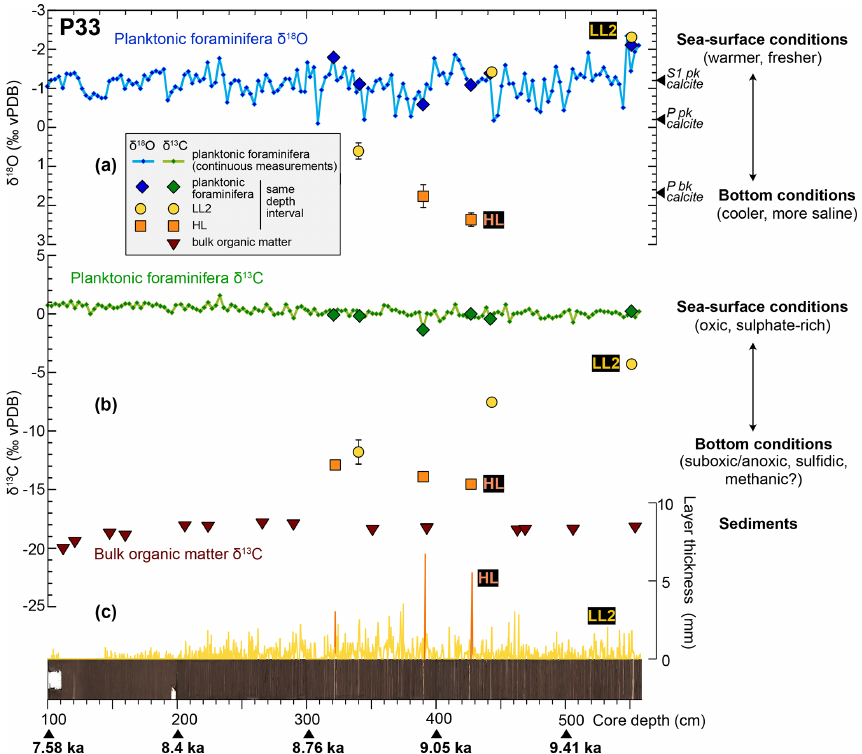
Figure 10. Changes in water-column stratification and chemistry as provided by isotopic composition of authigenic calcite in individual LL2 and HL of core P33. (a) δ 18 O of planktonic foraminifera (blue curve and diamonds), LL2 (yellow dots) and HL (orange squares), as compared to biogenic and inorganic calcite formed in equilibrium with seawater providing information on the water-column stratification as indicated on the right-hand side. (b) δ 13 C of planktonic foraminifera (green curve and diamonds), LL2 (yellow dots) and HL (orange squares) and bulk organic matter (brown triangles) showing the changes in water-mass oxygenation state. (c) Thickness of LL2 and HL, picture of the core surface, depth scale, and indications of